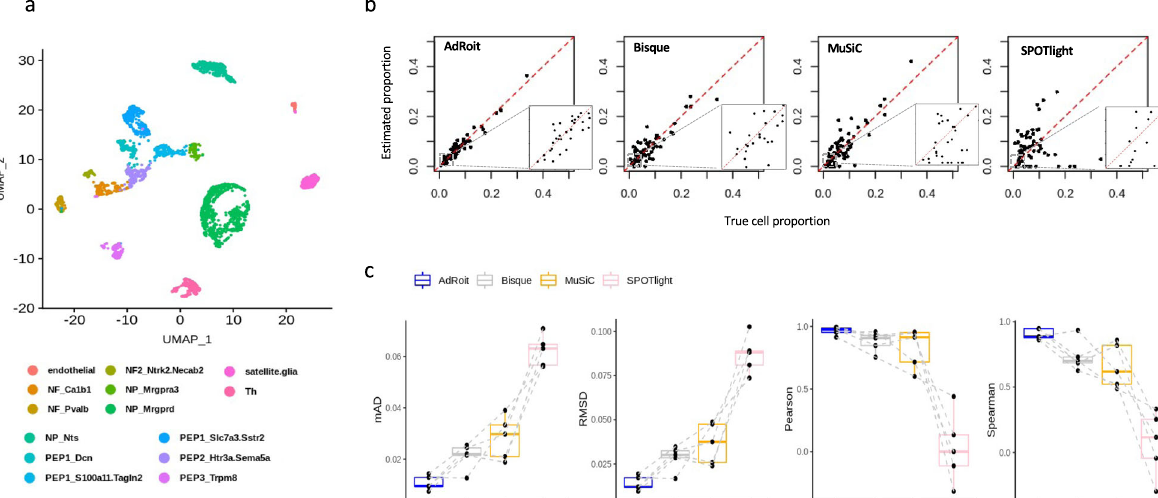
Fig. 4 Benchmark on simulated bulk data generated using mouse dorsal root ganglion (DRG) cells containing closely related subtypes of neurons. a 14 cell types are identi fi ed from scRNA-Seq samples of 5 mice, including multiple subtypes of neuro fi laments (NF), peptidergic (PEP), and non-peptidergic (NP) neurons. b Benchmarking with the synthetic data shows the cell type proportions inferred by AdRoit are more accurate. In particular, AdRoit remains a better accuracy when the cells are rare (e.g., <5%; see also the zoom-in inserts). Each dot represents a cell type from one sample. c For each sample, mAD, RMSD, Pearson, and Spearman correlations are compared across four methods. AdRoit has the lowest mAD and RMSD, and the highest Pearson and Spearman correlations. In addition, AdRoit ’ s estimation is the most stable across samples. Each boxplot was generated based on n = 5 distinct mice (one dot represents one animal). The bar of each boxplot indicates the 1.5× interquartile range. Same animals are chained by the dotted lines across the methods. The deconvolution was done by using the leave-one-out